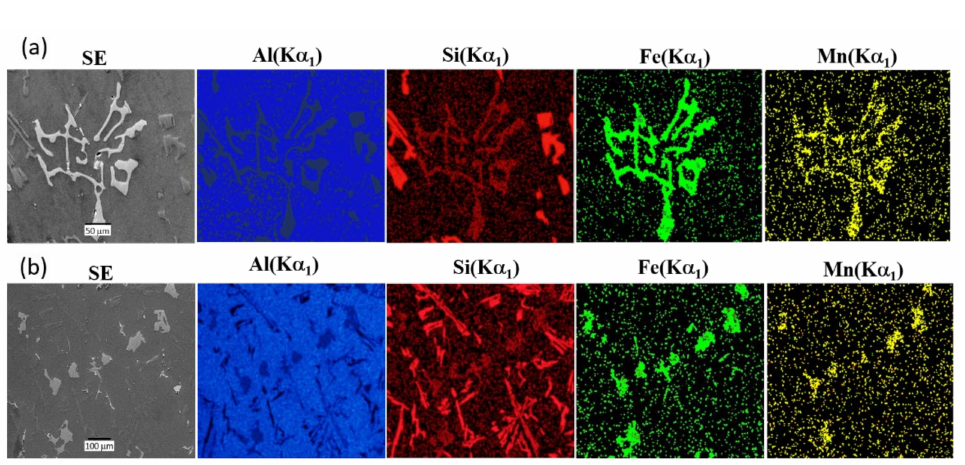
Figure 4. Mapping analysis of two different phases of iron. Chinese script ( a ), and irregular shape ( b